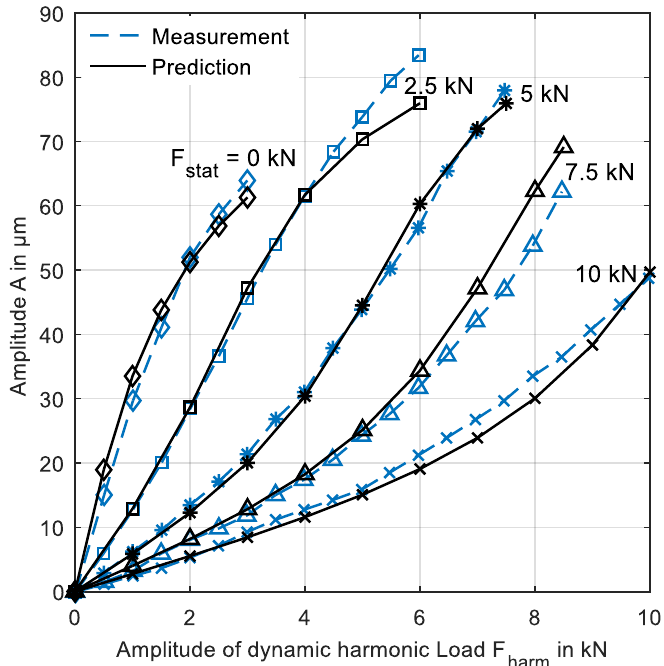
Figure 6. Measured [26] and predicted (NLIN) amplitudes of a 5-tilting-pad bearing for different static ( 𝐹 𝑠𝑡𝑎𝑡 ) and dynamic loads ( 𝐹 ℎ𝑎𝑟𝑚 ).